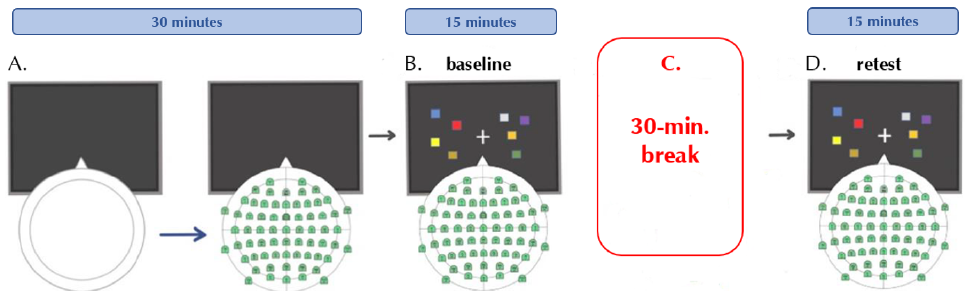
Figure 1. Schematic representation of the experimental session. ( A ) Setting up of the EEG cap. ( B ) Task performance at baseline. ( C ) 30 min break. ( D ) Task performance at